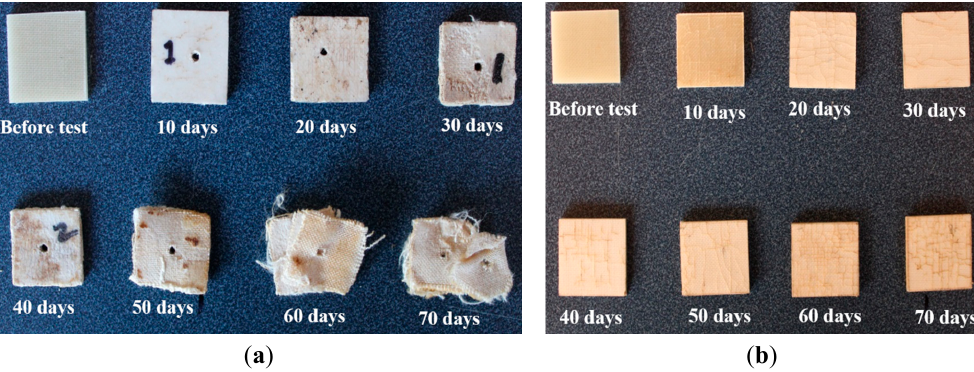
Figure 10. Biodegradation of bamboo fabric-reinforced PLA composites in controlled composting conditions ( a ) and real composting conditions ( b ).